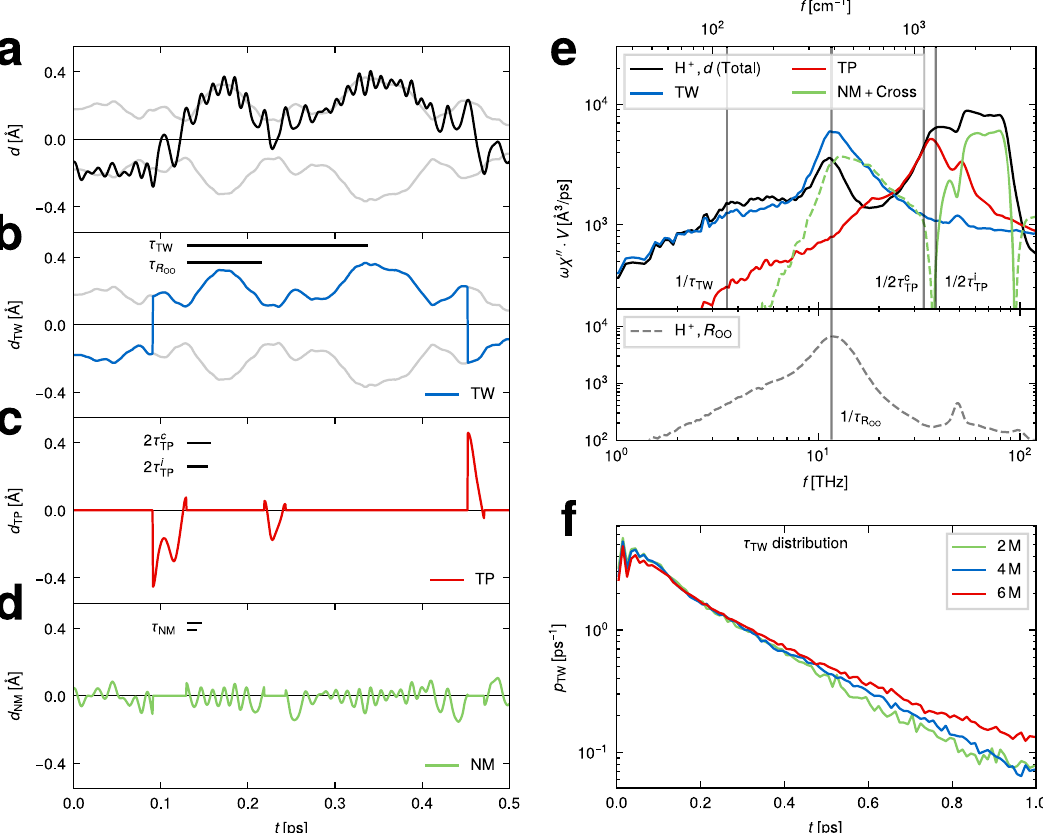
Fig. 5 Spectral signatures of proton transfer. a – d Decomposition of an excess-proton trajectory d ( t ) (black solid line in a ) into transfer-waiting d TW (blue solid line in b ), transfer-path d TP (red solid line in c ) and normal-mode contributions d NM (green solid line in d ). The time course of the R OO -dependent most likely proton positions at d * [ R OO ( t )] are shown as thin gray solid lines in ( a and b ). e IR spectrum of the excess-proton motion projected onto d , shown as a black solid line, and IR spectra of the contributions shown in a – c in the respective color (the green broken line denotes negative values). The power spectrum of the R OO coordinate is shown as a gray broken line in the lower panel. The inverse of the characteristic time scales τ TW , τ R 2 τ i are shown as thin vertical solid gray lines. f Distributions of the transfer-waiting fi rst-passage times of excess protons, see main text for TP